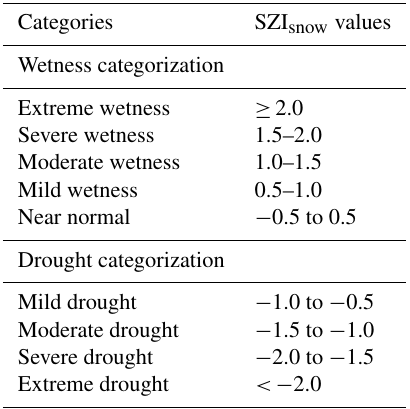
Table 2. Categorization of wetness and drought conditions in the SZI snow .